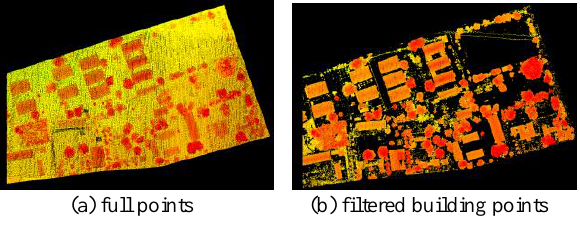
Figure 2. LiDAR point clouds of the study